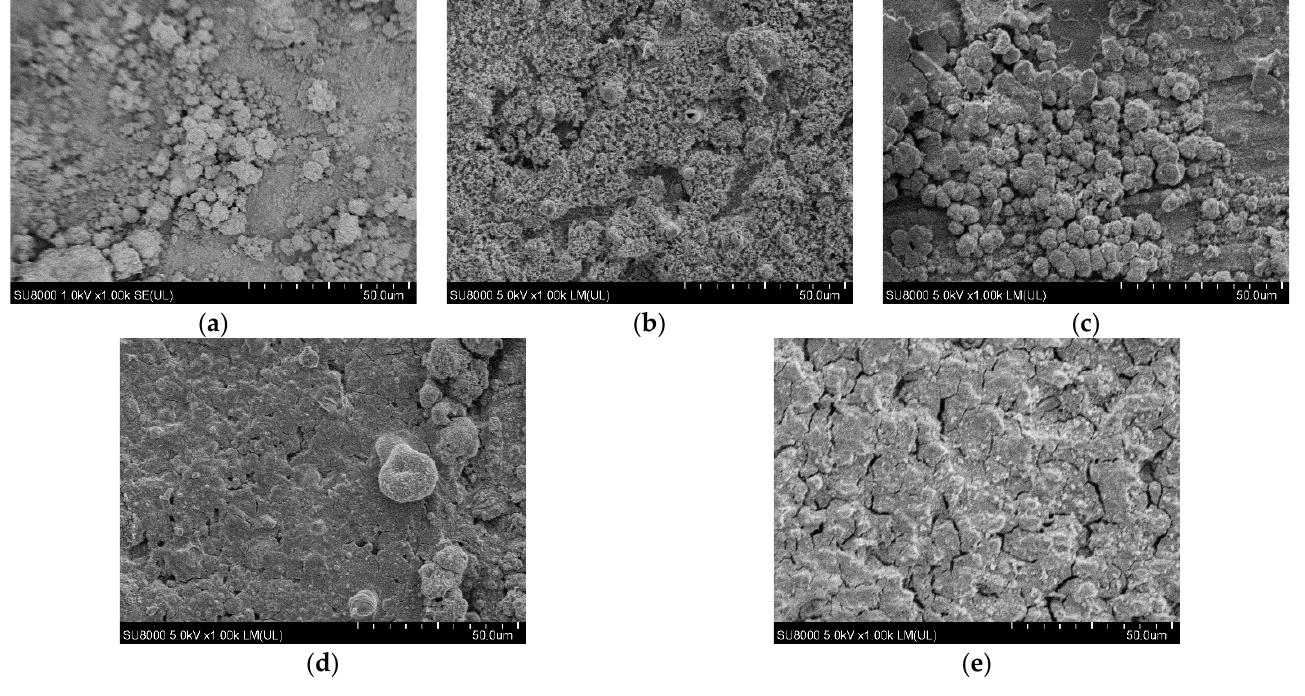
Figure 6. Microscopic corrosion morphology of hanging piece under different SRB content. ( a ) 0 pcs/mL; ( b ) 60 pcs/mL; ( c ) 120 pcs/mL; ( d ) 300 pcs/mL; ( e ) 600 pcs/mL.